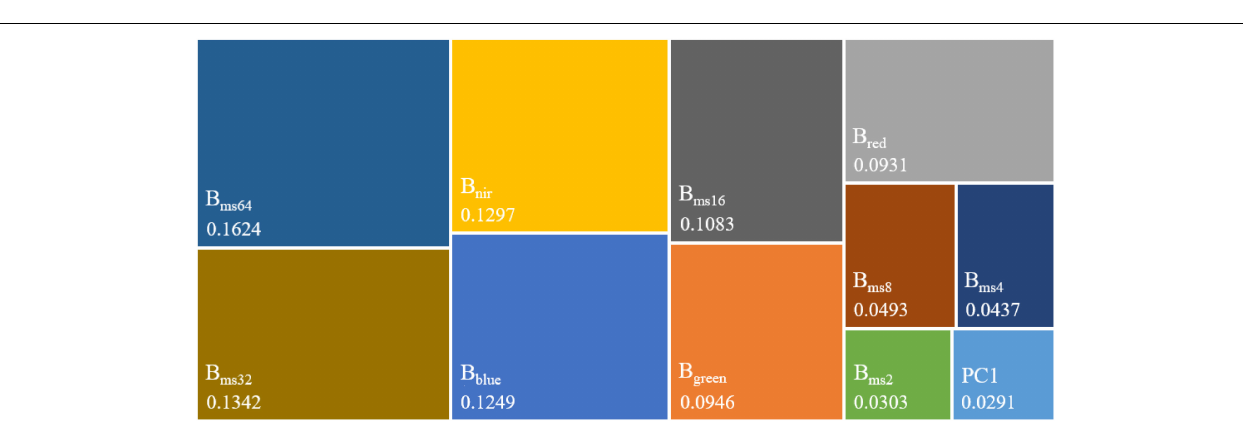
FIGURE 7 | The variance of the multi-scale feature images. (A–F) correspond to the variance of the B ms2 , B ms4 , B ms8 , B ms16 , B ms32 , and B ms64 , respectively.